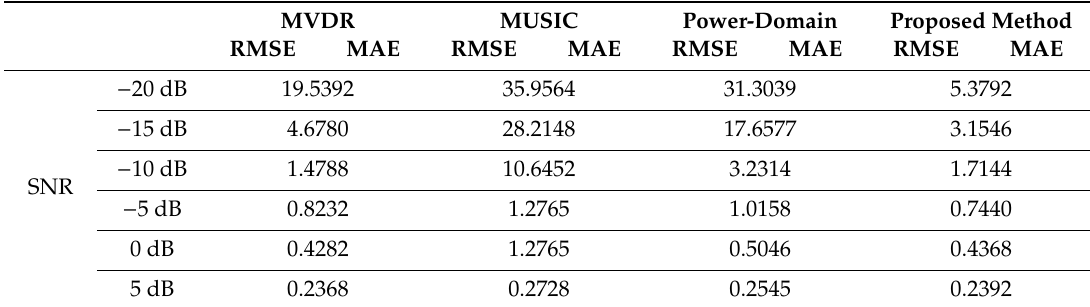
Figure 4. RMSE versus snapshot for the different estimators (MUSIC, MVDR, Power-Domain, and the proposed estimator) in Example 2.